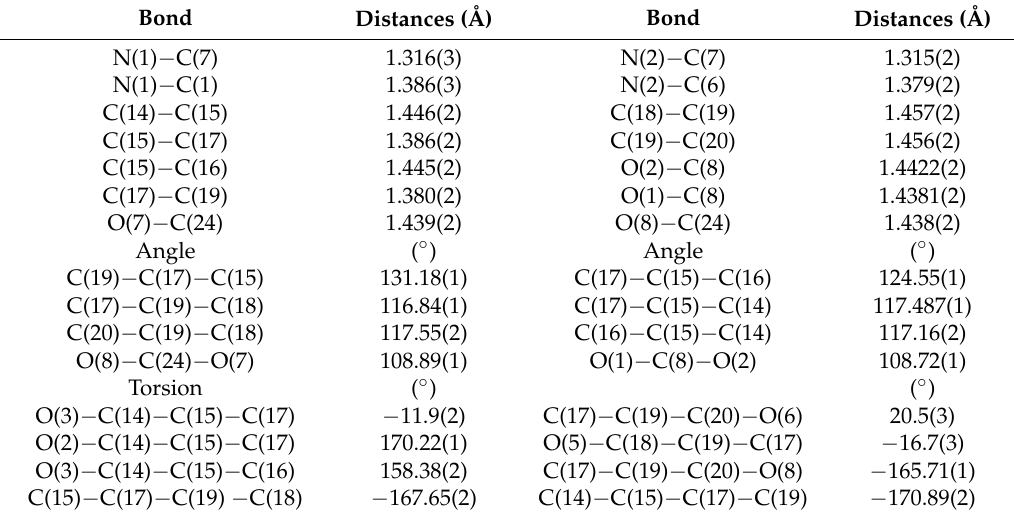
Table 1. Selected molecular structure parameters.